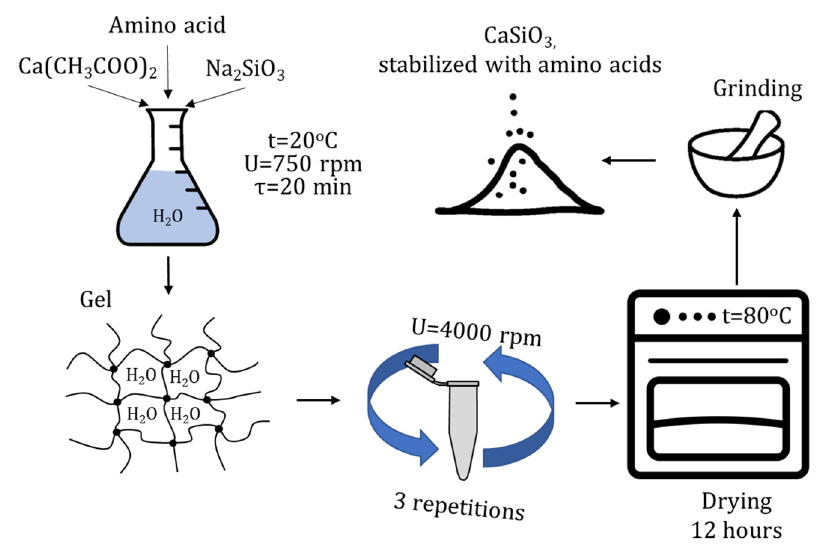
Figure 1. Scheme for the synthesis of calcium silicate nanoparticles stabilized with amino acids.